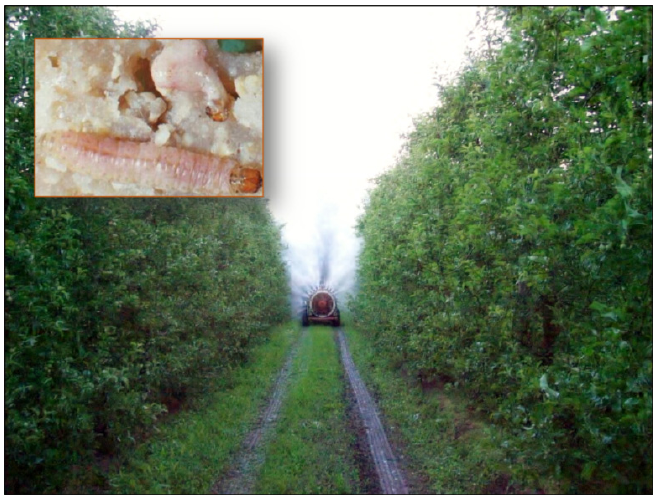
Figure 4. Application of Carpovirus Plus ® in apple orchards in Río Negro, Argentina. Inset: C. pomonella larvae infected by CpGV (Image kindly provided by Graciela. Quintana; Instituto de Microbiología y Zoología Agrícola, Instituto Nacional de Tecnología Agropecuaria (IMYZA.INTA), Castelar,